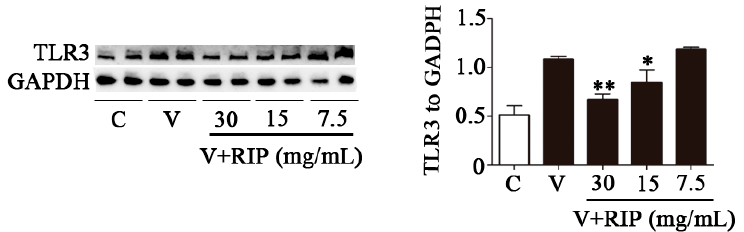
Figure 3. Radix isatidis polysaccharides can reduce the expression of TLR3 induced by PR8/H1N1 virus. 16HBE cells were infected with PR8/H1N1 virus (MOI = 1), then treated with R. isatidis polysaccharides. After 24 h, Western blotting was performed to assess the TLR3 protein level, and GAPDH protein was used as a control. RIP: R. isatidis polysaccharides. Statistical significance was evaluated using the Student’s t -test, relative to the mock-infected cells ( * p < 0.05, ** p < 0.01).